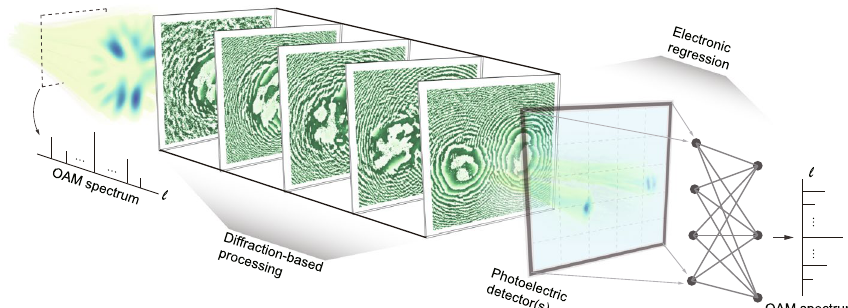
Fig. 1 Illustration of the hybrid processor for OAM spectrum measurement. The incident structured light with certain OAM distribution is firstly processed by the diffractive optical neural network, whereby the OAM information is transformed into high-dimensional sparse feature in the photoelectric detector plane. For this model, the optical-diffraction-based processing part can ‘split’ the input beam into two main lobes that are related to positive and negative topological charges respectively. Once the complex optical field is turned into real-numbered intensity patterns, the shallow fully connected layer can recover the OAM spectrum in a regressive manner (see detailed model in